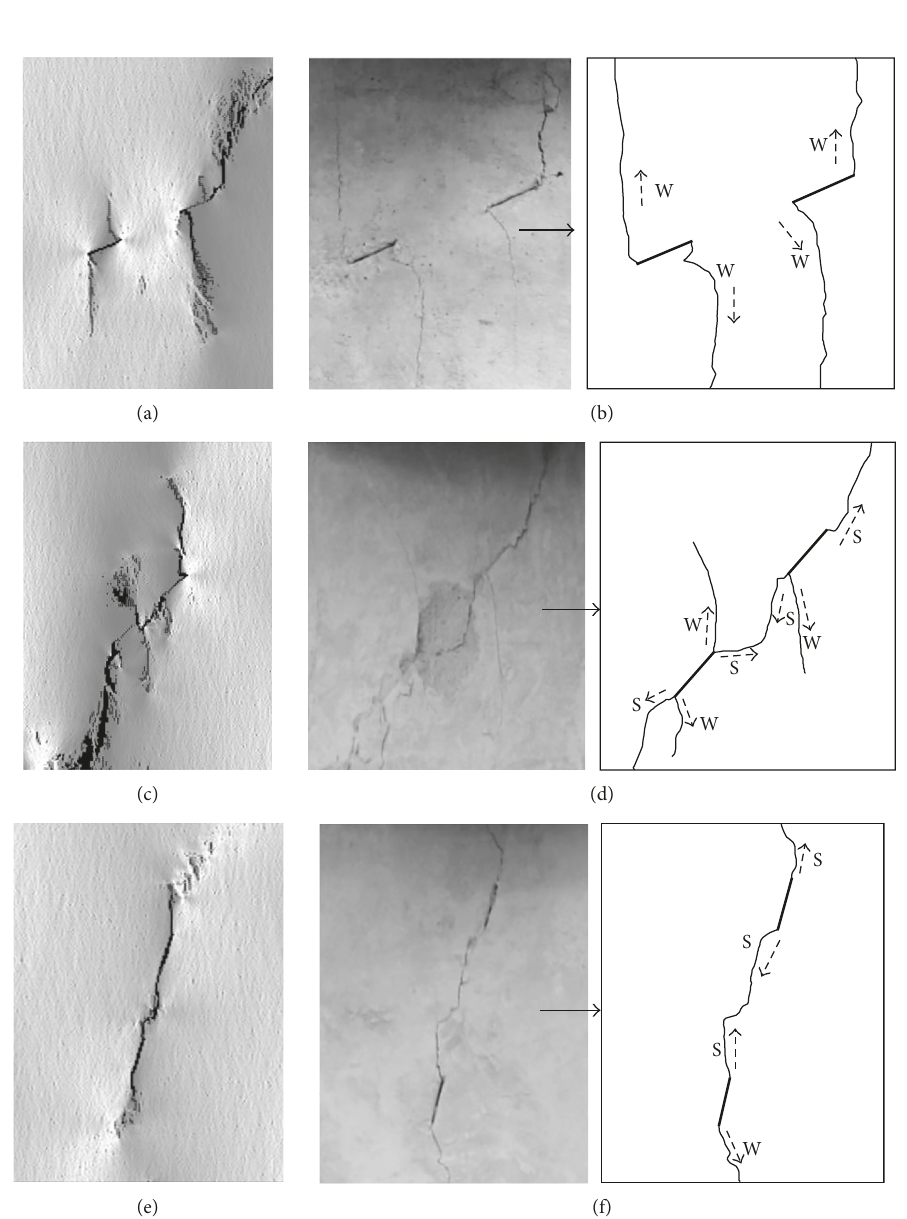
Figure 9: Comparison of numerical results and experimental results for two equal collinear cracks with varied inclination angles a , d ( a 1 40mm; W wing crack; S shear crack). (a) Simulation results for β 2 (cid:31) 20mm (cid:31) (cid:31) (cid:31) (cid:31) 45 ° . (f) Experimental results for β (c) Simulation results for β 45 ° . (d) Experimental results for β (cid:31) (cid:31)